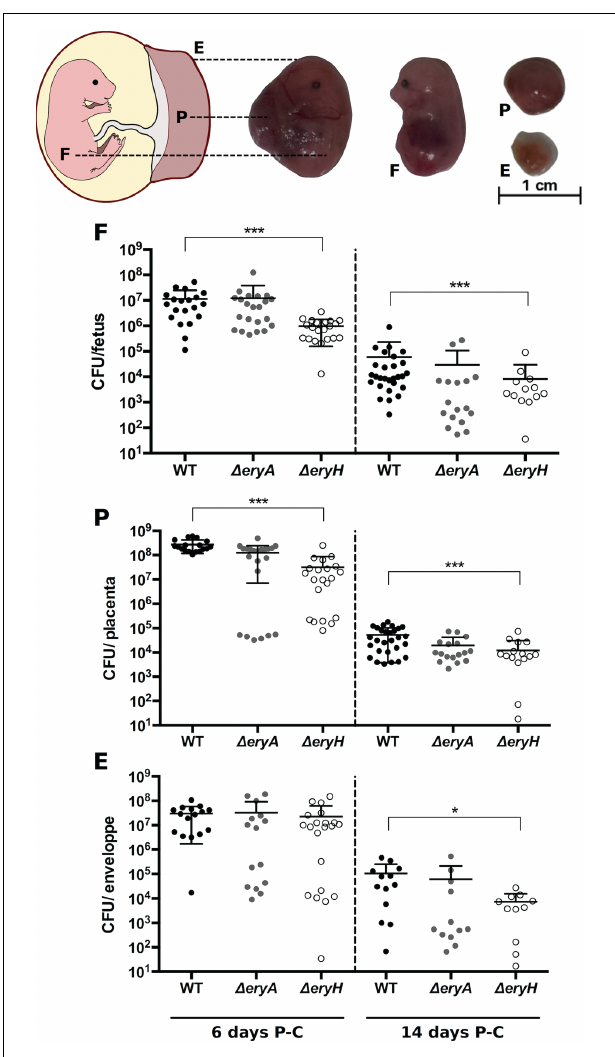
FIGURE 5 | Brucella abortus (cid:49) eryH but not (cid:49) eryA show reduced ability to colonize the mouse conceptus. Pregnant C56BL/6 mice were inoculated intraperitoneally with 10 5 B. abortus 2308 WT, (cid:49) eryH or (cid:49) eryA mutant at 6 or 14 days post conception (P-C). At day 15 P-C, individual conceptuses were dissected to separate the placenta (P), the fetus (F) and the fetal envelopes (E) and CFU determined. Each dot represents the CFU counts obtained from one conceptus and bars represent the mean ± standard deviation ( ∗∗ p < 0.01; ∗∗∗ p < 0.001; Mann–Whitney